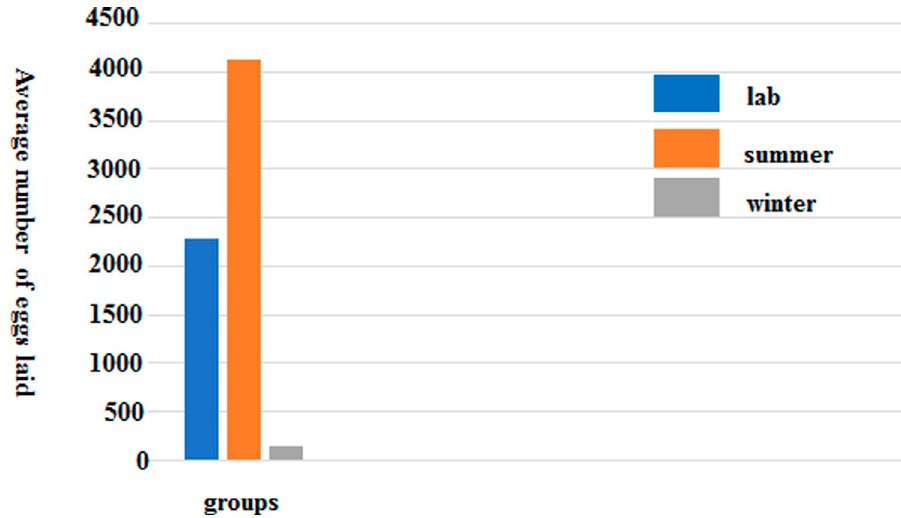
Fig 5. Egg production of adult Ae . albopictus